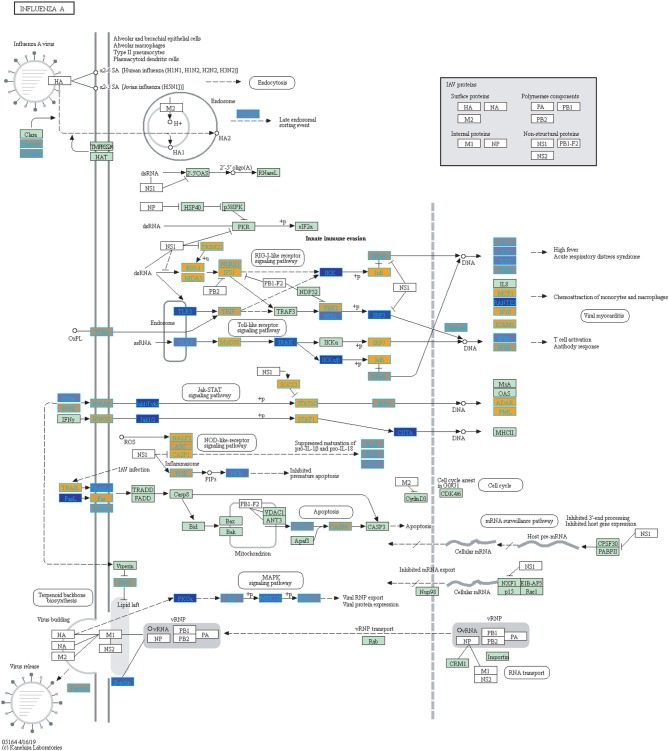
Highlighted Influenza A KEGG Pathway (hsa05164) with Enriched Genes from the LRT analysis (Bonferroni-adjusted p < 0.05) for Influenza Infected Subjects (47–49). Yellow-colored genes are up-regulated and blue-colored genes are down-regulated in Influenza Infected Subjects.